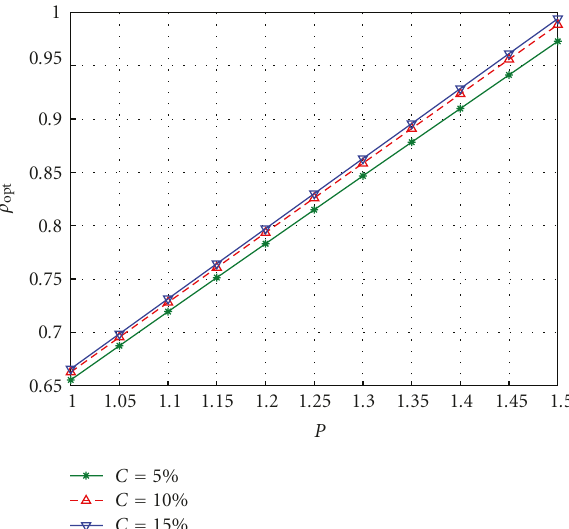
Figure 6: The optimal ρ 0,opt versus P for di ff erent C.